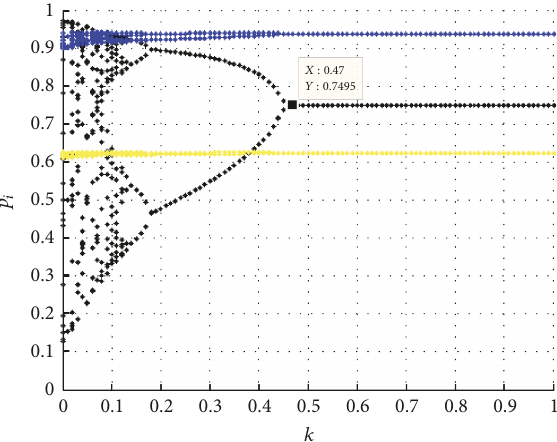
Figure 6: Chaos unilateral control factor on system stability. Figure 7: Chaos tripartite control factor on system